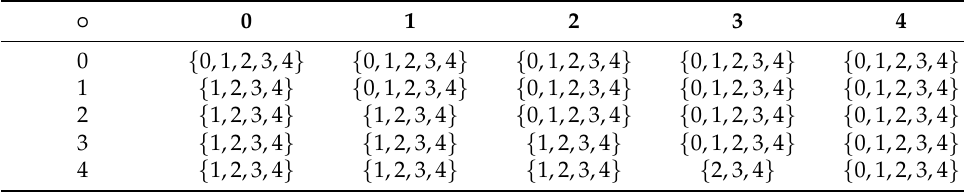
Table 18. Generalized quasi-left alter quasi-hyper BZ -algebra.